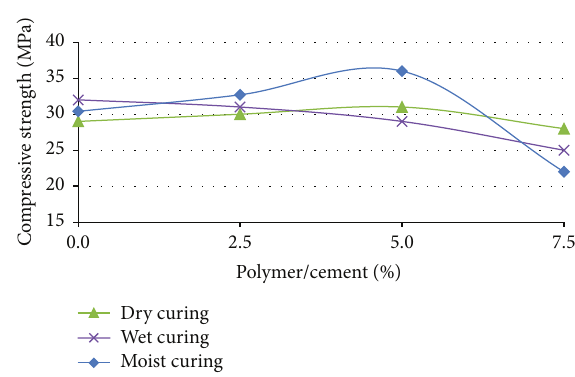
Figure 11: The effect of curing methods on the compressive strength at different polymer contents and 15% MK at age of 28 days.